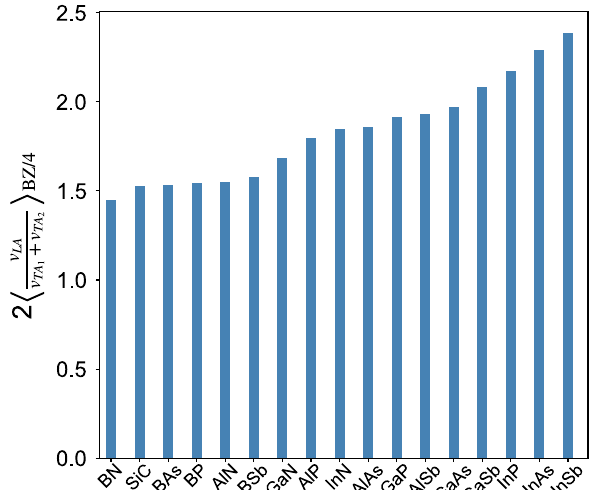
FIG. 6. Ratios of the LA phonon velocities to the mean TA phonon velocities averaged over 1 = 4 of the BZ centered at the Γ point for 17 zinc blende compounds. The compounds are listed in ascending order of the mean LA-TA velocity ratio. Compounds with the largest velocity ratios have the AAA # 2 selection rule